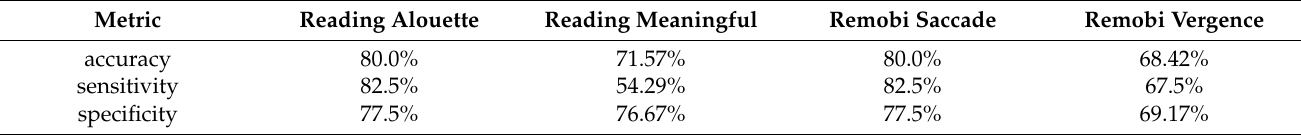
Table 2. Support Vector Machine scores for Analysis 1.